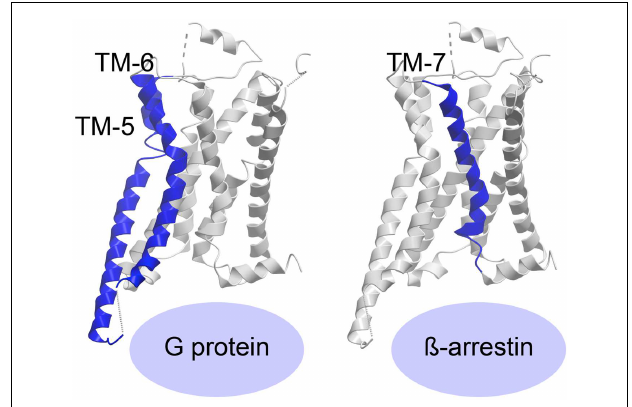
FIGURE 3 |Activation of a 7TM receptor .The active β 2 -adrenergic receptor withTM-5 and -6 or -7 highlighted in blue according to their importance for receptor interaction with G protein or β -arrestin, respectively.The structures are visualized with Molsoft Browser